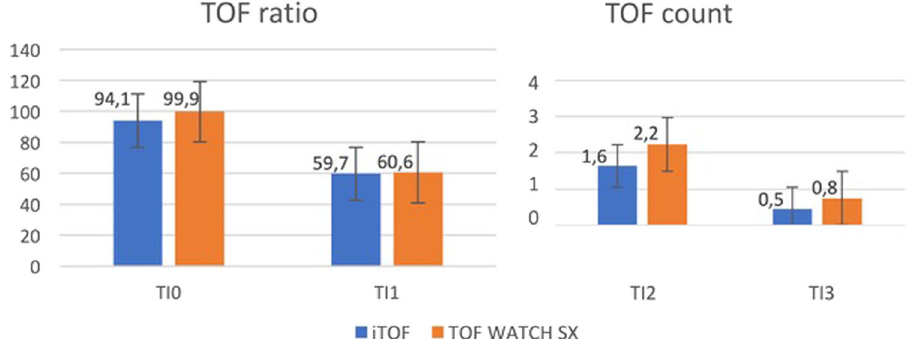
Fig. 2 Neuromuscular parameters during the induction to general anesthesia. Diagram comparing means of the TOF ratio (left side, expressed in percentage) and TOF count (right side, expressed in absolute value) between i-TOF and TOF WATCH SX among the different induction